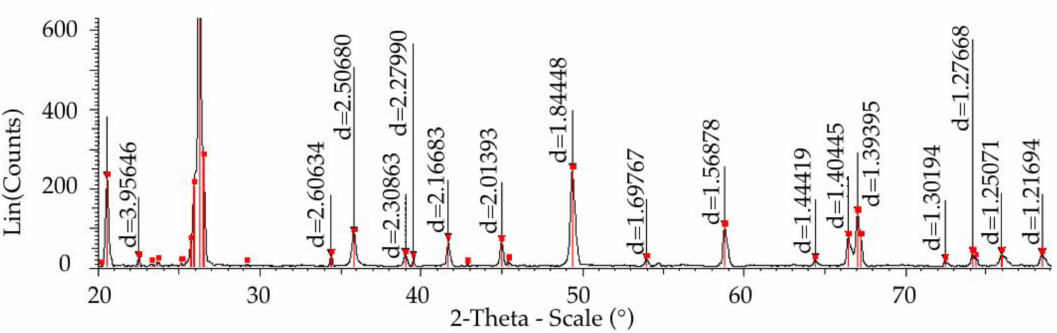
Figure 9. Quartzite diffractogram, taken at 879 ◦ C, characterizing the appearance of cristobalite with z = 7.16 Å.